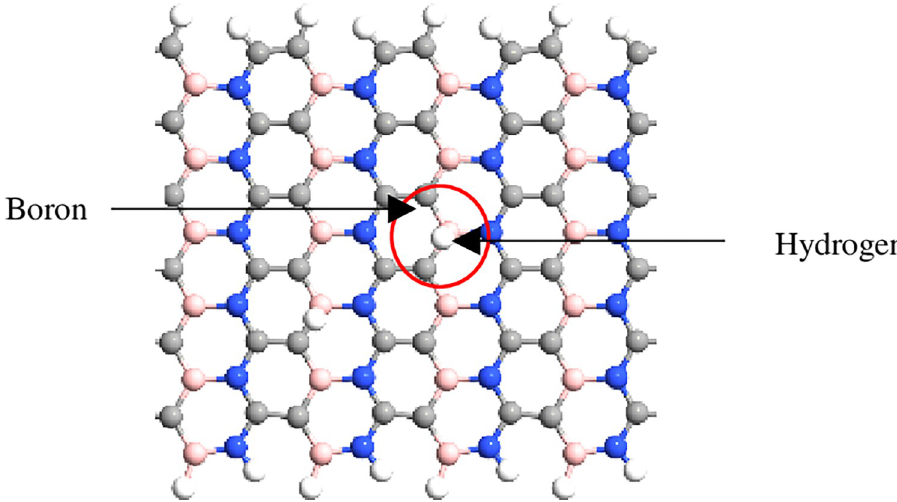
Fig 6. Optimized structures of 12-BC 2 NNR with multiple H 2 gas molecules in different positions at boron